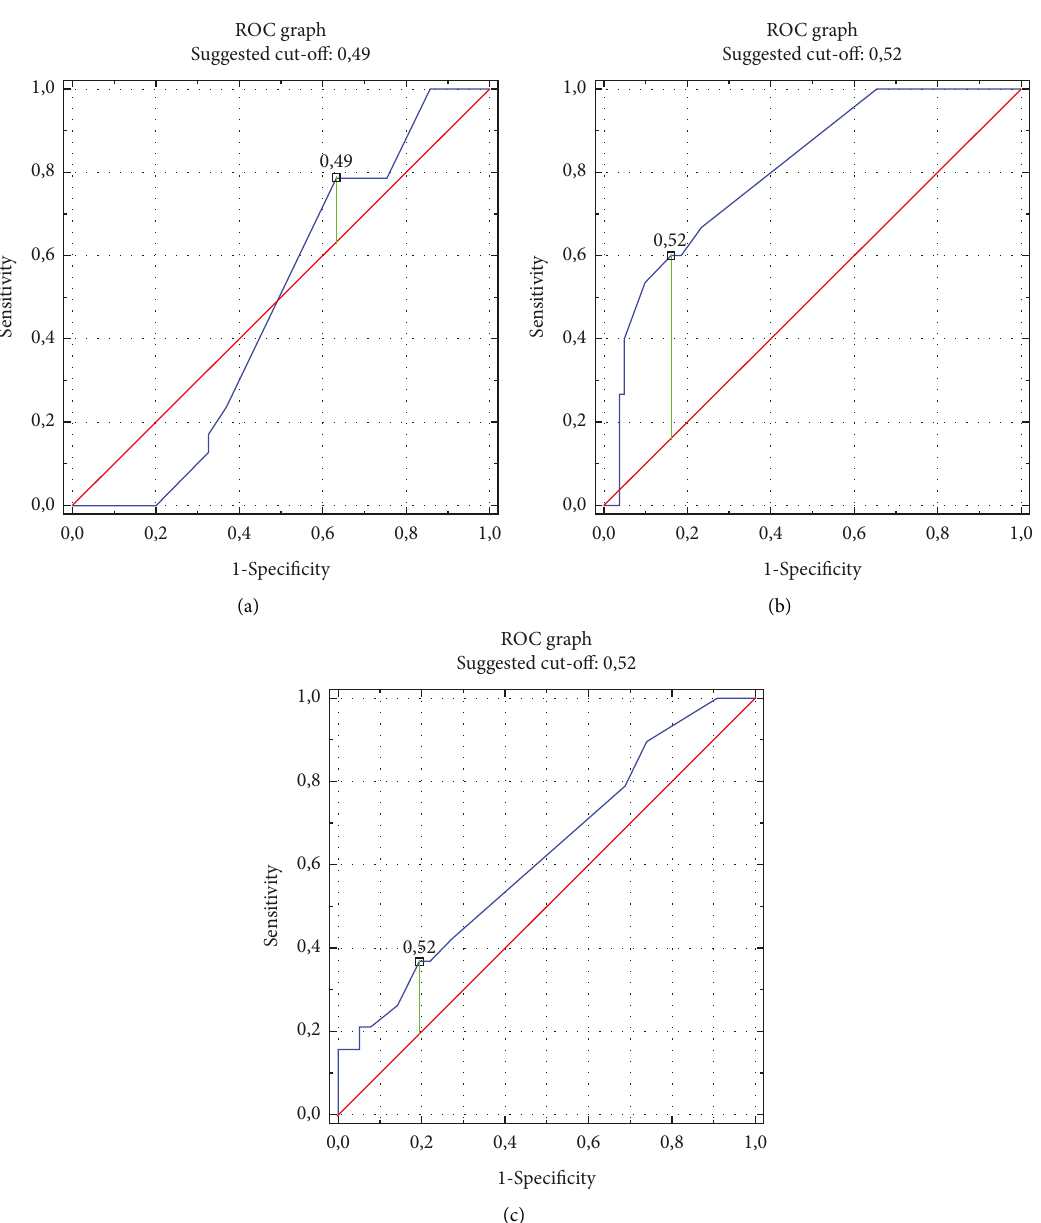
Figure 3: ROC curves for predicting left ventricular geometry using the CTR value on the chest radiograph. (a) CR: concentric remodeling of the left ventricular. (b) CH: concentric hypertrophy of the left ventricular. (c) EH: eccentric hypertrophy of the left